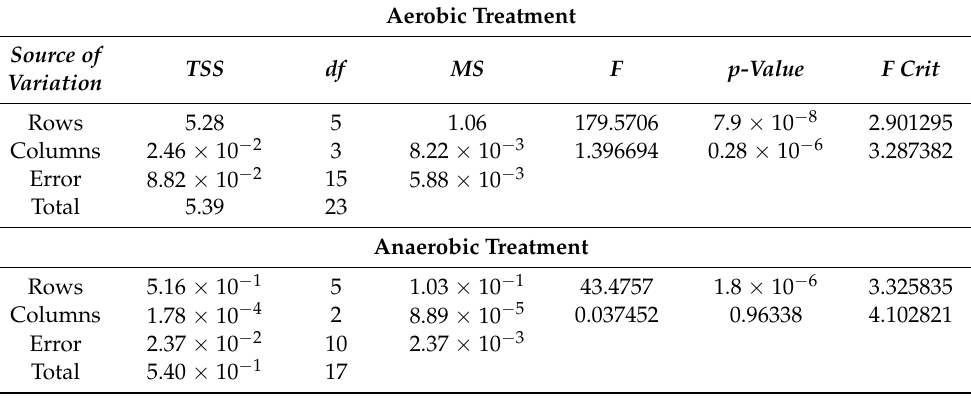
Table 3. Analysis of variance (ANOVA) test of TSS reduction in aerobic and anaerobic treatment.